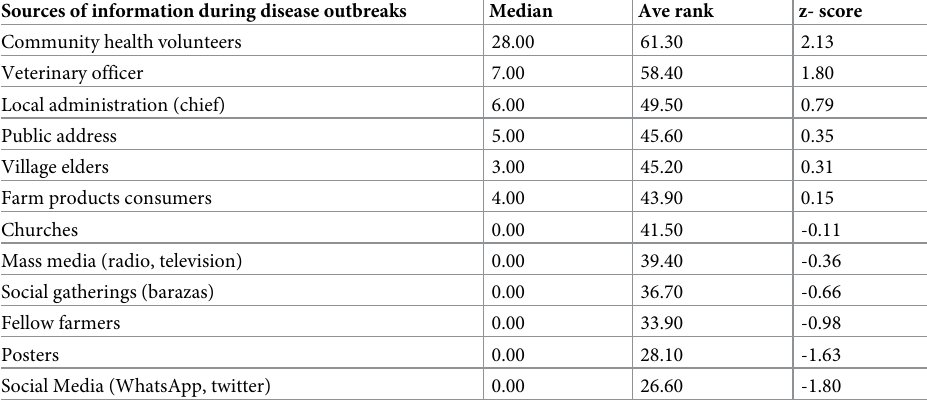
Table 5. Source of Information during Disease Outbreaks, Nakuru, Kenya, 2020. Sources of information during disease